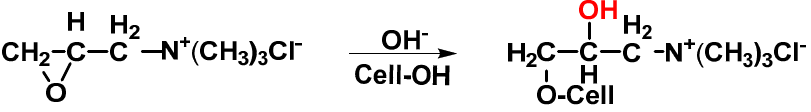
Figure 3. Reaction equation of GTA with cotton fiber.